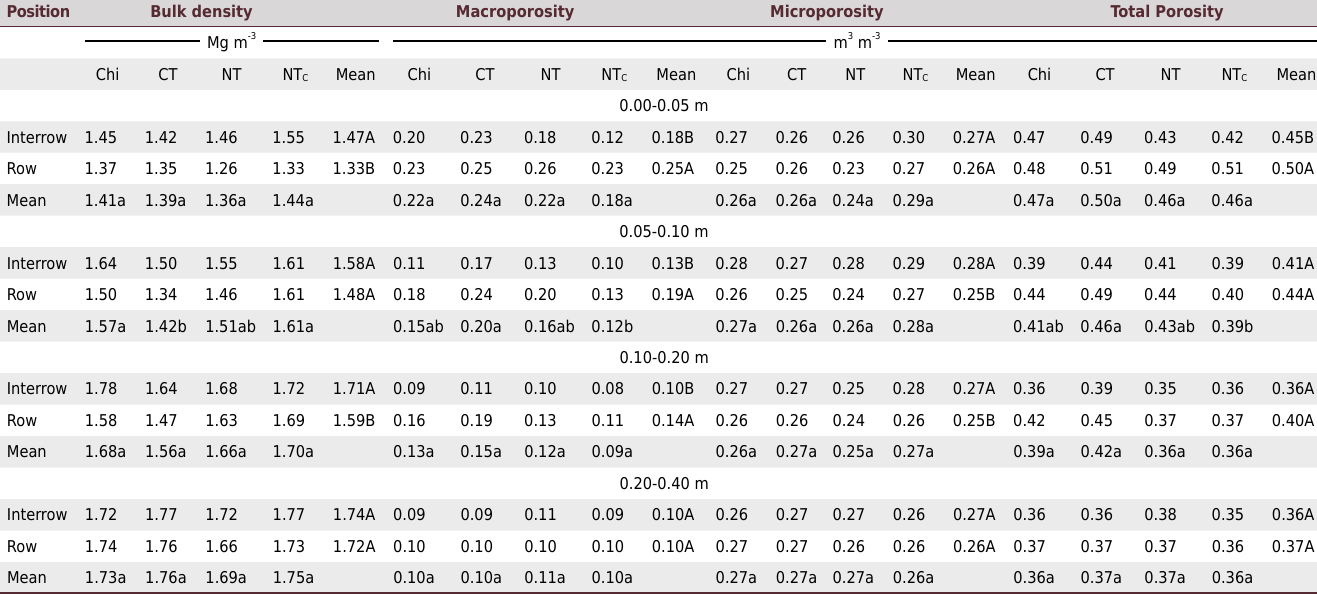
Table 3. Soil bulk density, macroporosity, microporosity, and total porosity, in four soil layers and tillage methods, in interrow and row one month after planting of the cassava crop Position Bulk density Macroporosity